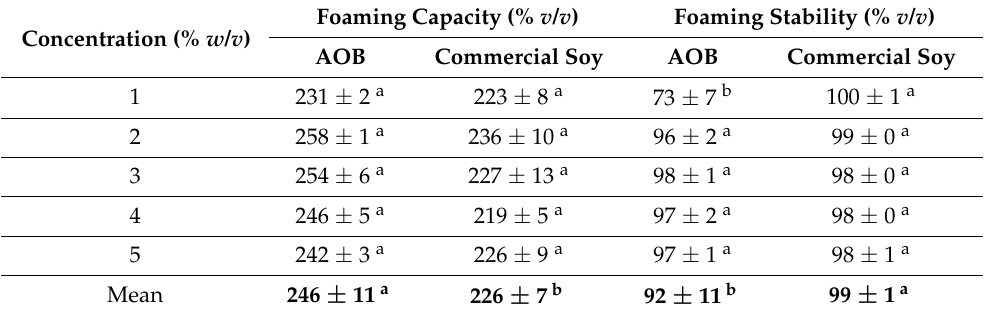
Values are expressed as means of three replicates ± standard deviation. Letters: Represent the Tukey test for multiple comparisons between soy and AOB and among the concentrations (interaction between protein isolates and their concentration). Mean values with the same letter in rows are not significantly different ( p ≤ 0.05). Values in bold are means of the main effects of AOB and commercial soy protein